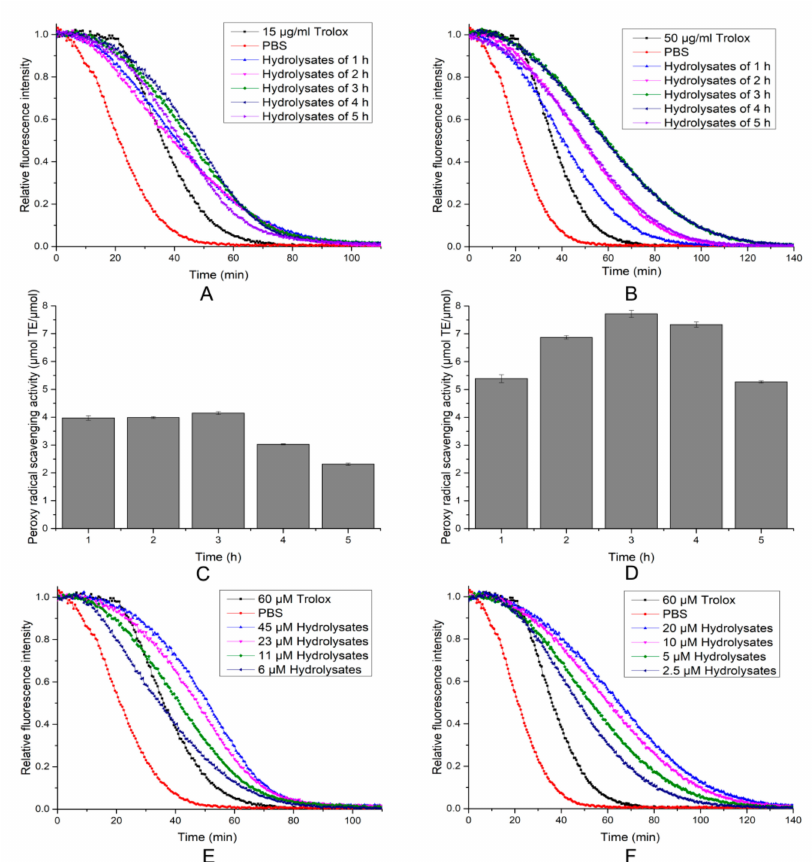
Figure 8. Peroxyl radical scavenging activity (oxygen radical absorbance capacity (ORAC) assay) of hydrolysates. ( A , C ) Peroxyl radical scavenging activity of salmon skin collagen hydrolysates with di ff erent times. ( B , D ) Peroxyl radical scavenging activity of porcine skin collagen hydrolysates at di ff erent times. ( E ) Peroxyl radical scavenging activity of salmon skin collagen hydrolysates at di ff erent concentrations. ( F ) Peroxyl radical scavenging activity of porcine skin collagen hydrolysates at di ff erent concentrations. Values are expressed as the mean ± SD ( n =